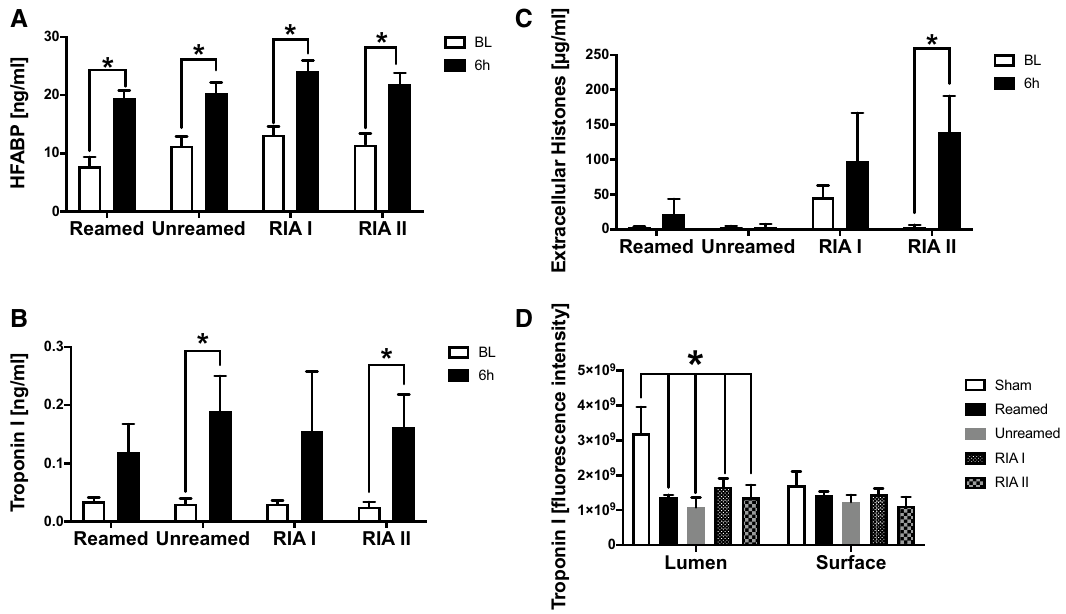
Figure 1. Myocardial Damage: ( A ) Systemic Heart-Fatty Acid Binding Protein (HFABP) in ng/ml in serum samples of pigs at Baseline (white) and 6 h after femur fracture (black) and either nailing (unreamed), reaming (reamed), Reamer-Irrigator-Aspirator 1 (RIA1) or RIA 2. ( B ) Systemic Troponin I measured in ng/ml in serum samples. ( C ) Systemic elevation of extracellular histones in µg/ml serum bevor and after femur fracture. ( D ) Quantitative analysis of troponin stained section of the left ventricle 6 h after femur fracture. n = 5 in each group, data were presented as ± SEM, *p ≤